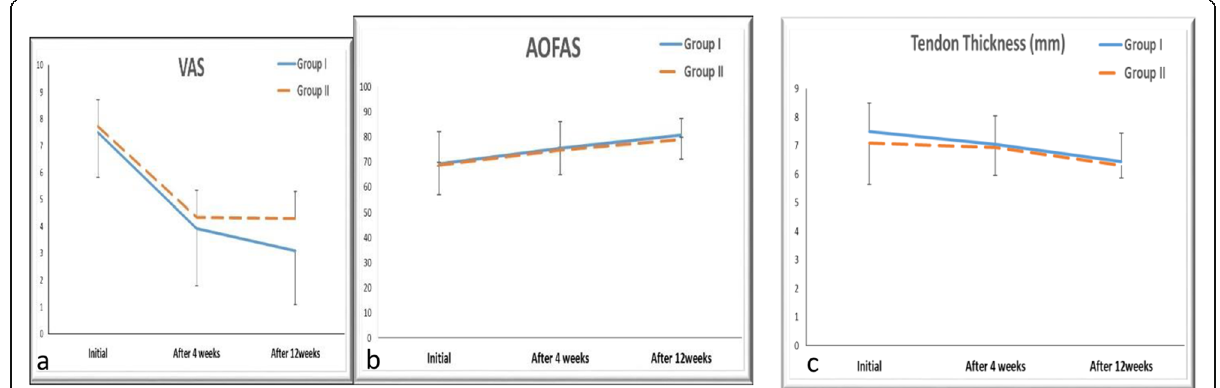
Table 3 Comparison between two groups as regards AOFAS score initially, at 4 weeks, and after 12 weeks AOFAS Initial After 4 weeks After 12 weeks Paired t test